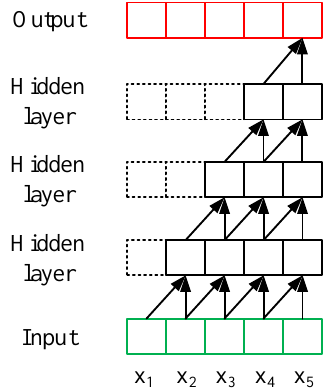
Figure 3. Visualization of a stack of causal convolutional